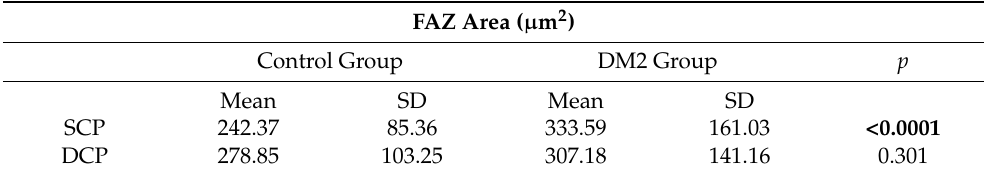
Figure 2. Mean and standard deviation (SD) of vascular density (%) of the superficial (SCP) and deep (DCP) retinal plexuses, the choriocapillaris (CC), measured using DRI Triton SS-OCT in patients with DM2 and in healthy controls and their comparison. The measurements were divided into 5 quadrants (abbreviated C, Central; S, Superior; T, Temporal; N, Nasal; I, Inferior). Differences that reached statistical significance ( p < 0.05) are shown in grey. Table 3. Mean and standard deviation (SD) of the foveal avascular zone (FAZ) ( µ m 2 ) of the superficial (SCP) and deep (DCP) retinal plexuses. Differences that reached statistical significance ( p < 0.05) are shown in